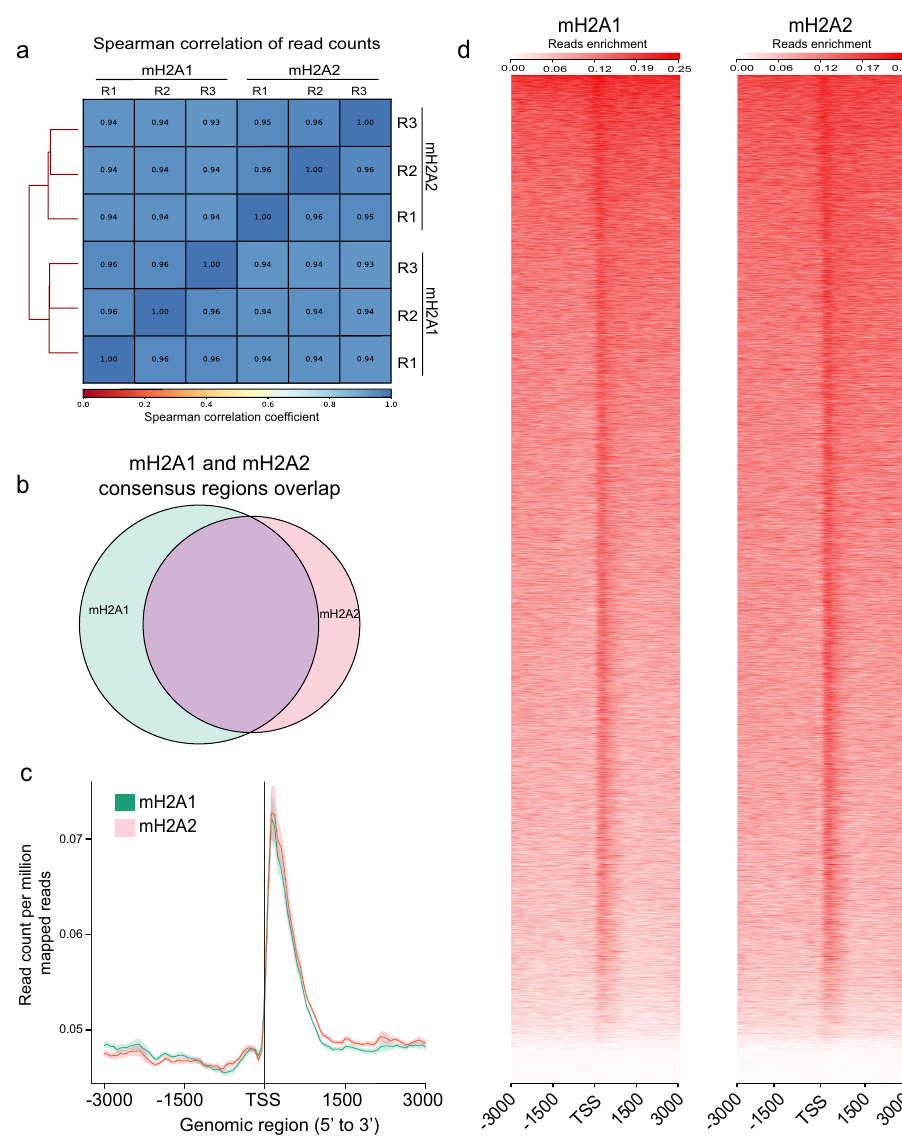
Fig. 3 Characterisation of mH2A1 and mH2A2 binding in area CA2 of the hippocampus. a Correlation analysis of mH2A2 and mH2A2 binding for each of the three experimental replicates (R1-R3) of untrained control mice shows that mH2A1 and mH2A2 binding is strongly related. b Venn diagrams demonstrate the high level of overlap between mH2A1 and mH2A2 regions in untrained mice. c Average pro fi le plot of mH2A1 and mH2A2 signal at TSS- fl anking regions. d Heatmap of mH2A1 (left) and mH2A2 (right) enrichment at TSS- fl aking regions. Heatmap is relating TSS regions ranked based on mH2A1 and mH2A2